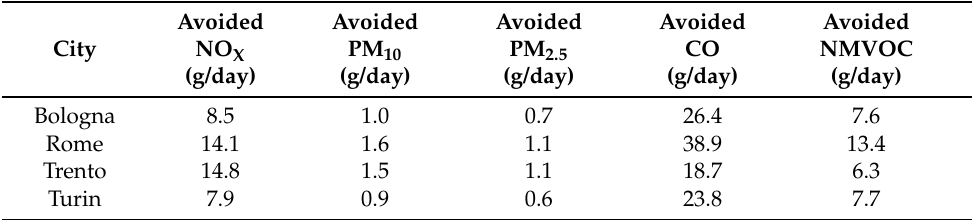
Table 7. Selected average avoided daily pollutant emissions per capita for remote workers travelling exclusively or partially by car for each